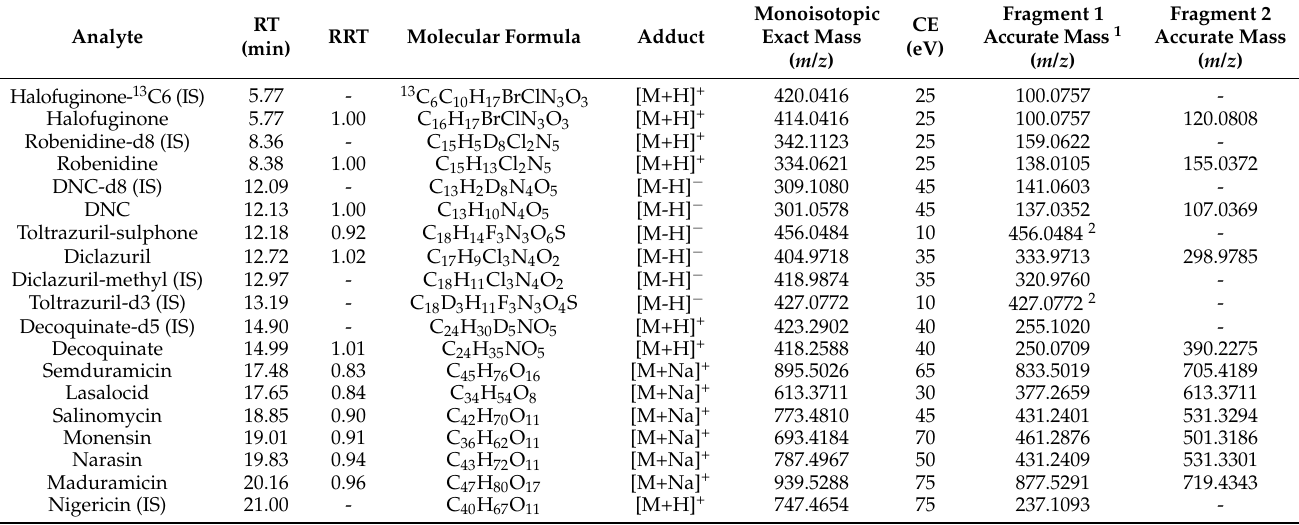
Table 1. LC-Q-Orbitrap parameters of the investigated